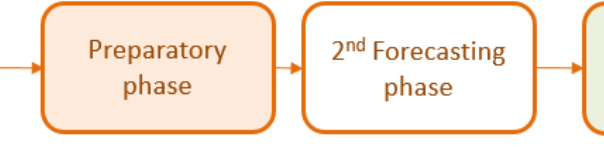
Figure 8. The market process diagram of the Business Use Case.